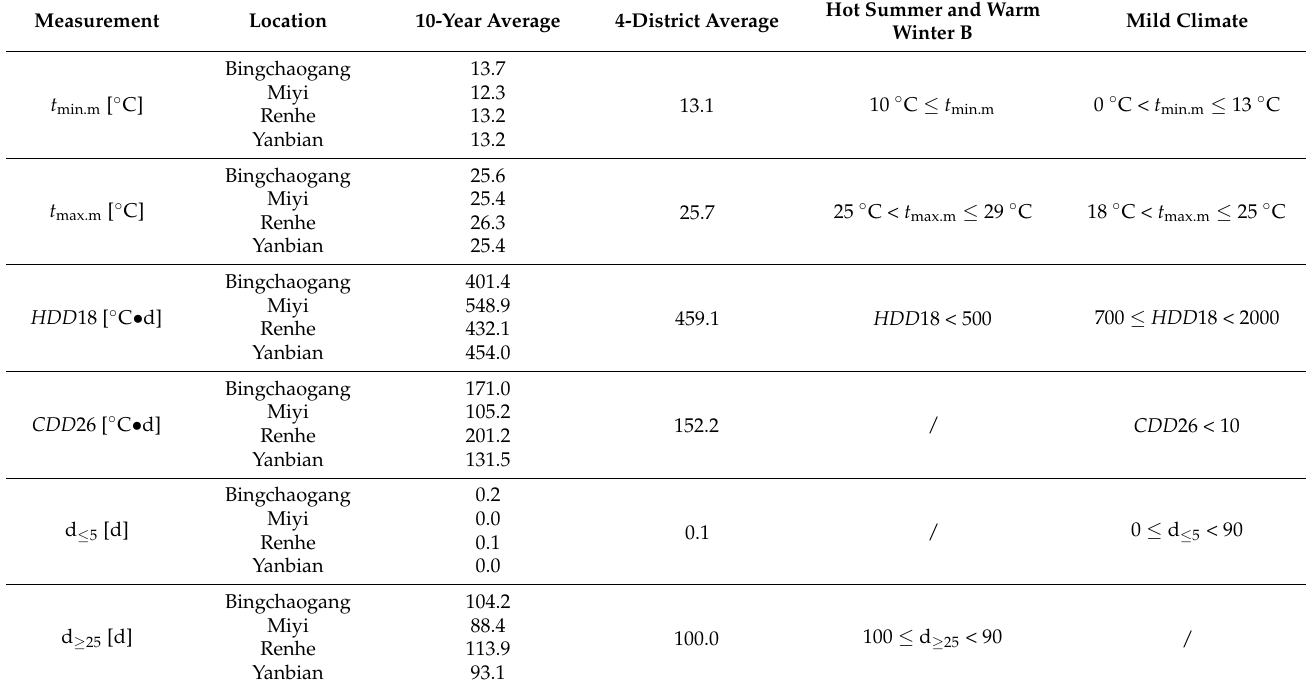
Table 2. 2009–2018 Statistical results of meteorological parameters in Panzhihua.